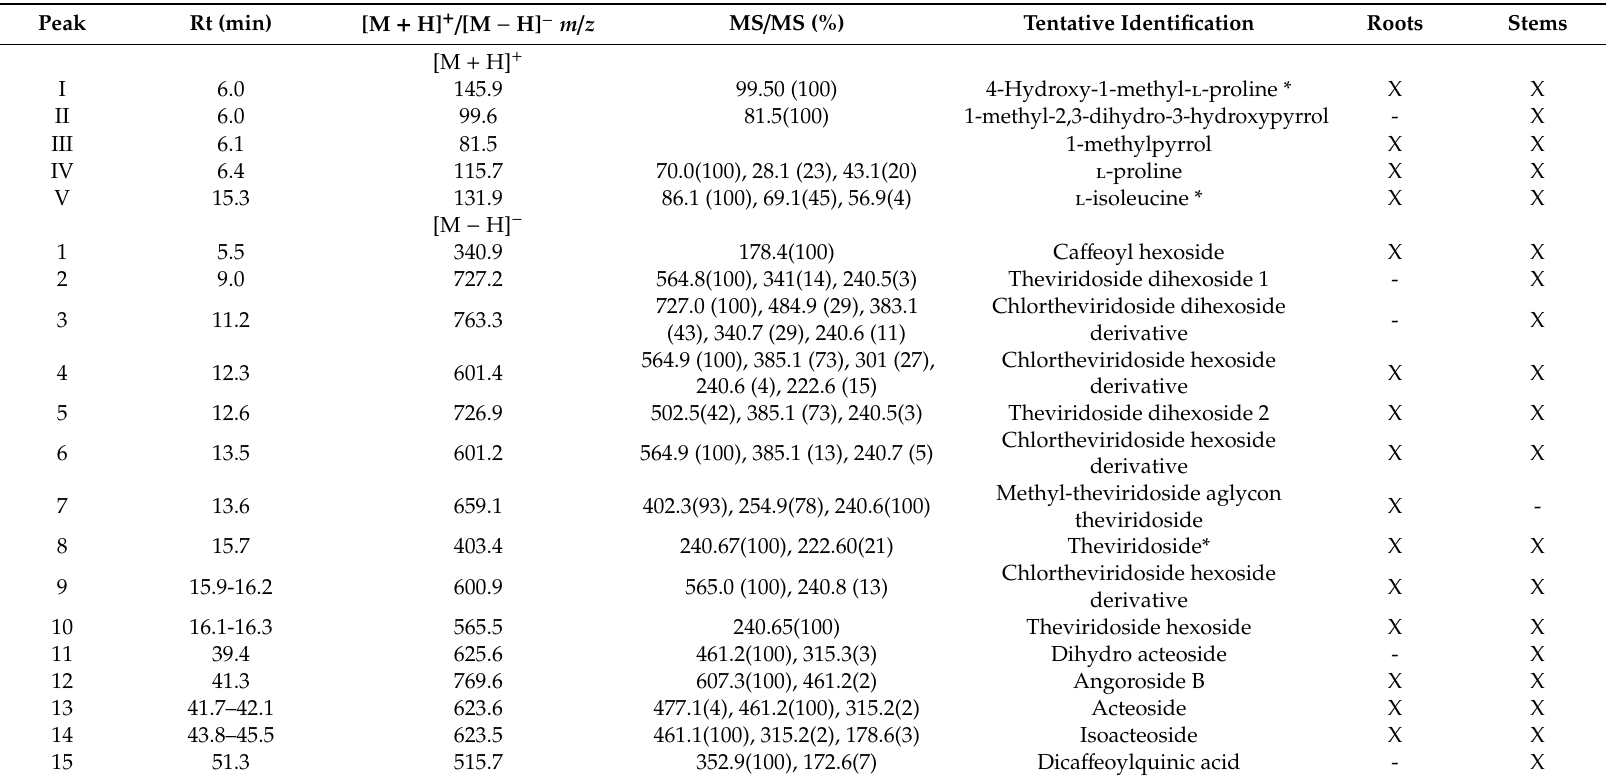
Table 4. Tentative identification of compounds from root and stem hydroalcoholic extracts of Adenocalymma marginatum by HPLC-ESI-MS / MS in the negative ion mode and distribution in roots and